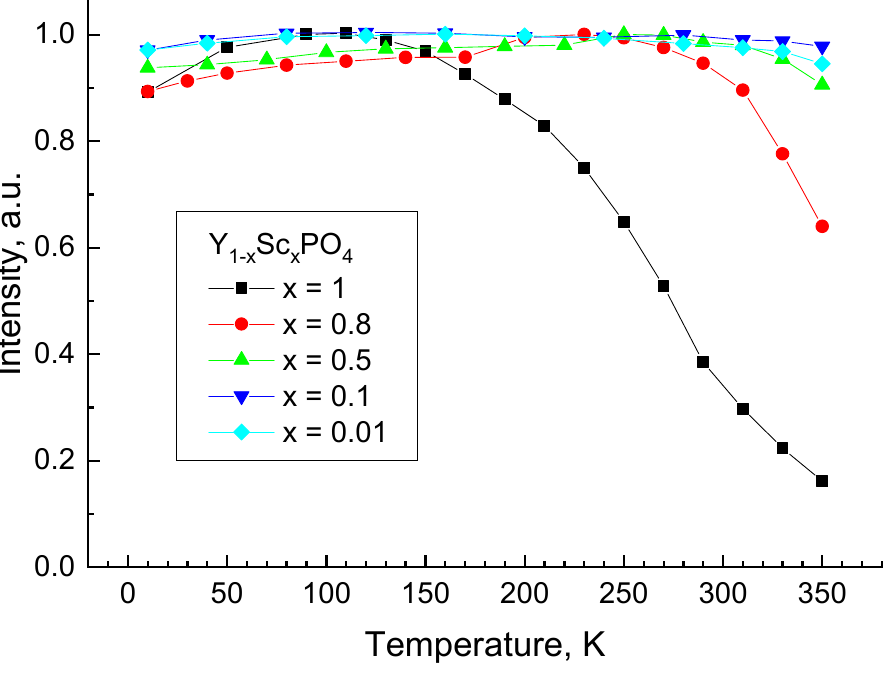
Figure 5. Temperature dependence of the UV-C band emission intensity in Y 1 − x Sc x PO 4 at E ex = 7.75 eV ( λ ex = 160 nm). The points were obtained by integrating of the PL signal in the wavelength region 190–265 nm ( x = 1), 190–290 nm ( x = 0.8) and 190–310 nm ( x = 0.5, 0.1 and 0.01).